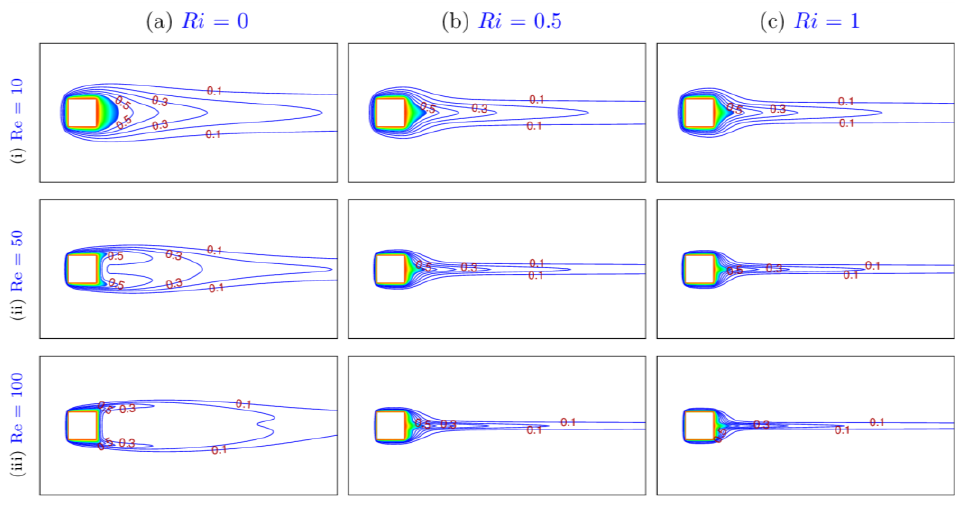
Figure 10. Time-averaged isotherms for different values of Re and Ri at φ = 5% : ( a ) Ri = 0, ( b ) Ri = 0.5, ( c ) Ri = 1.